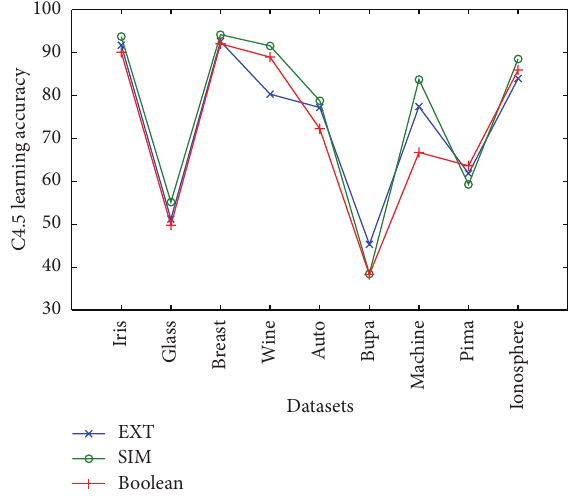
Figure 2: Comparison of C4.5 performance on 9 UCI real datasets.